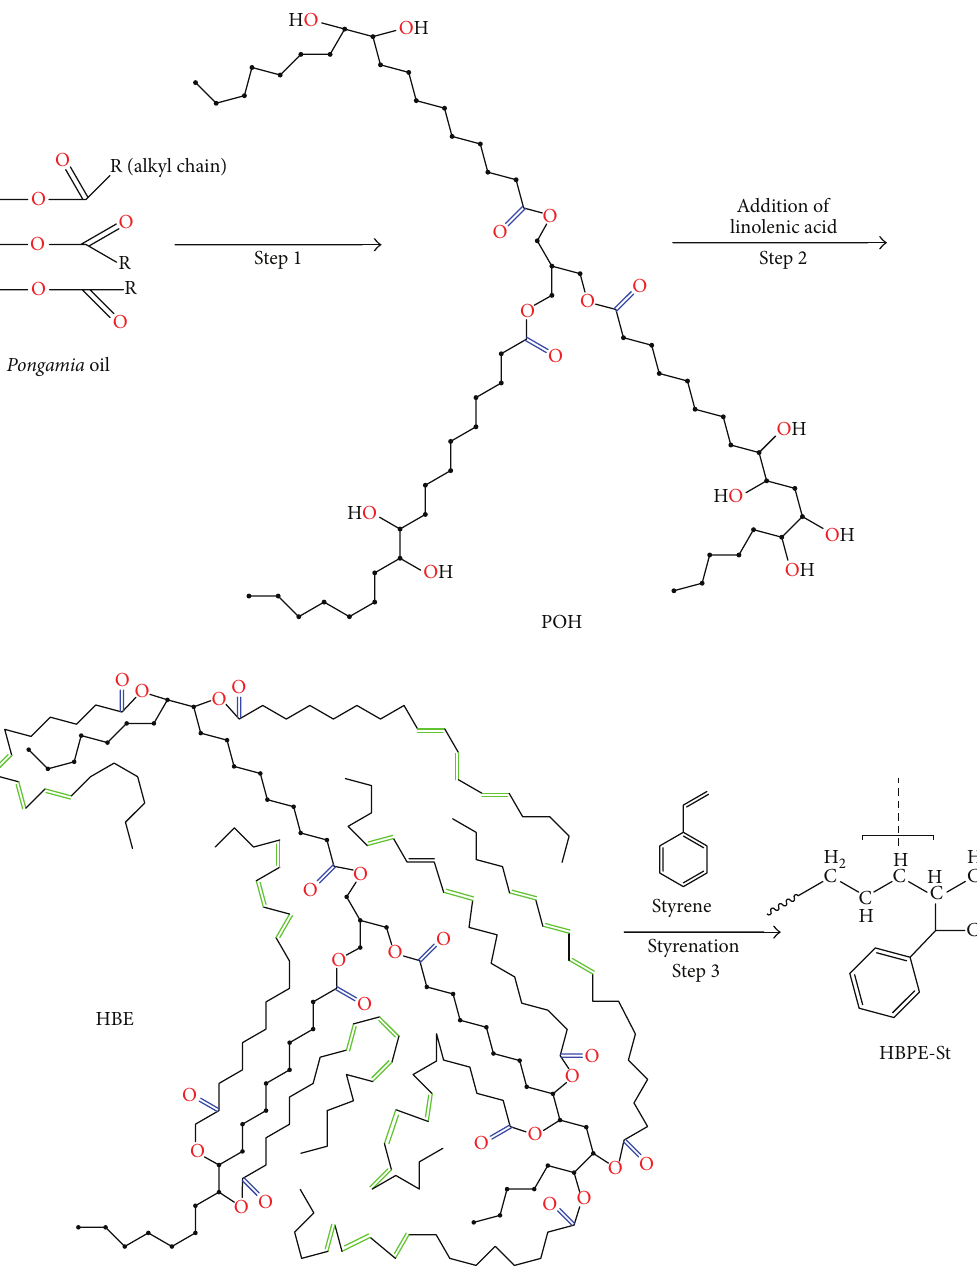
Scheme 1: Schemes synthesis of hyperbranched polyester-styrene